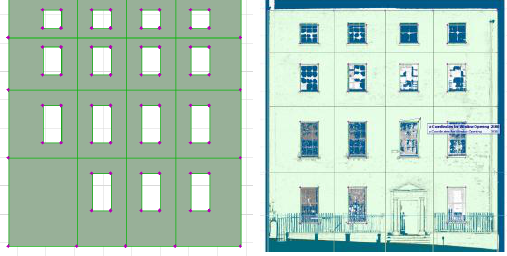
Figure 14. Wall Façade with editable points (hotspots) used for graphical editing (left) and wall façade overlaid with orthographic image (right).